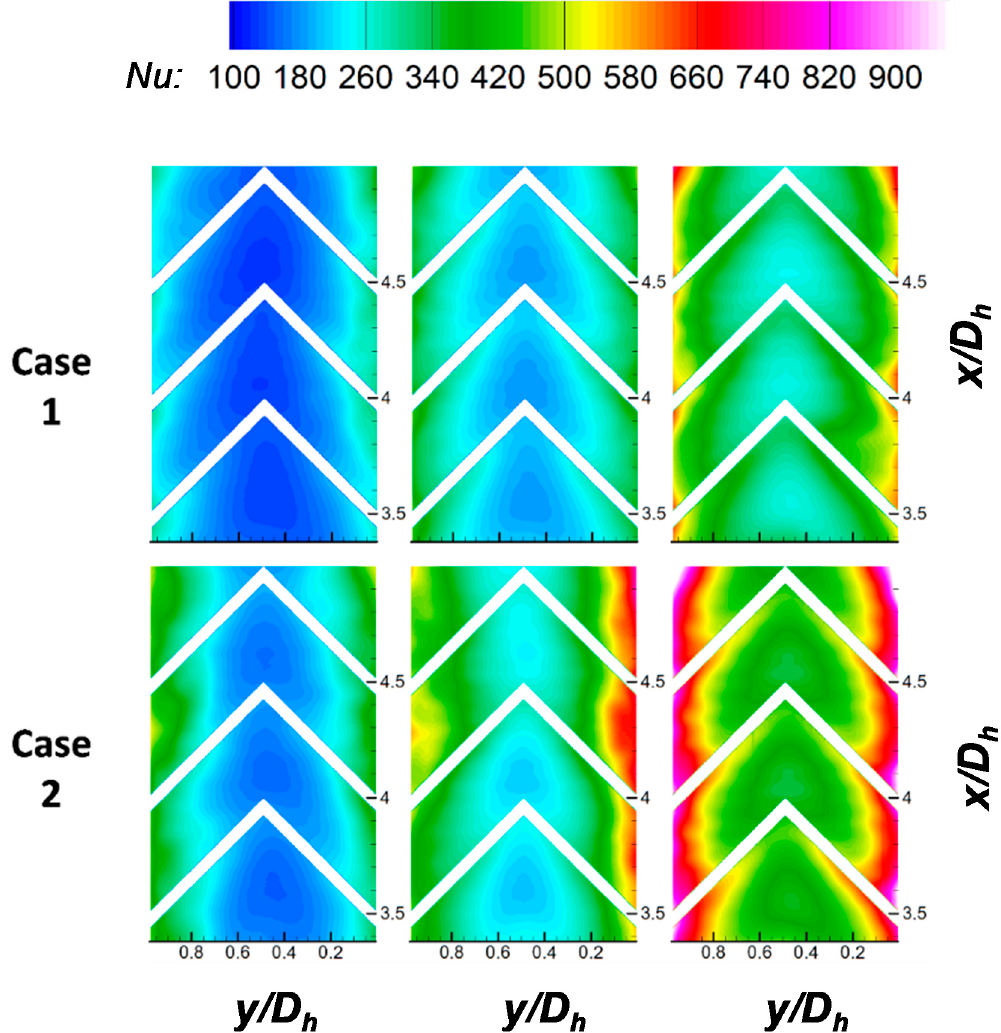
Figure 7. Nusselt number distribution of the mist flow on the V-shaped ribbed surface ( P / e = 10).